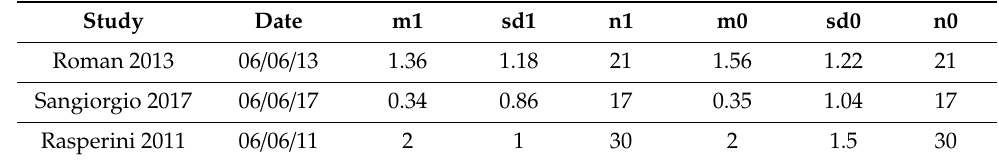
Table A4. Stata 15 IC Grid for